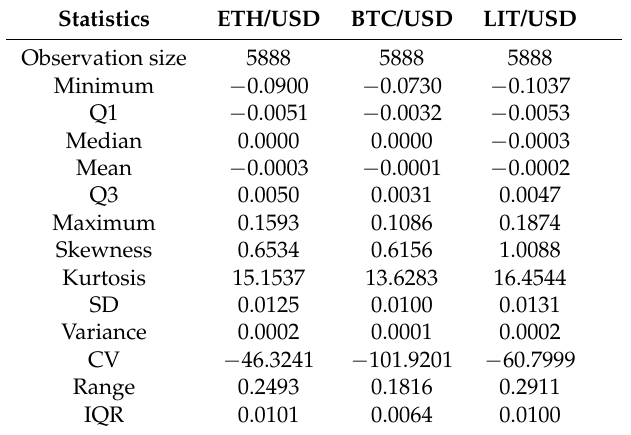
Table 2. Summary statistics of log returns of hourly market price index during bear market in ETH/USD, BTC/USD and